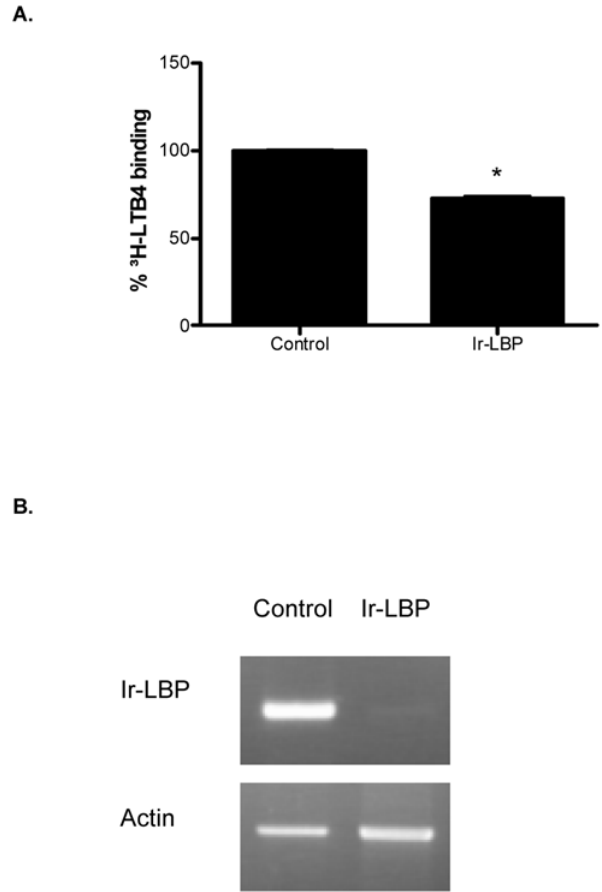
Figure 8. Ir-LBP knockdown in tick salivary glands. A) Eight pairs of salivary glands were incubated for 6 h with control or Ir-LBP siRNA. Five m g of salivary gland extracts were incubated with 2 nM of 3 H-LTB4. B) RT-PCR analysis of RNA from control and Ir-LBP siRNA-treated salivary